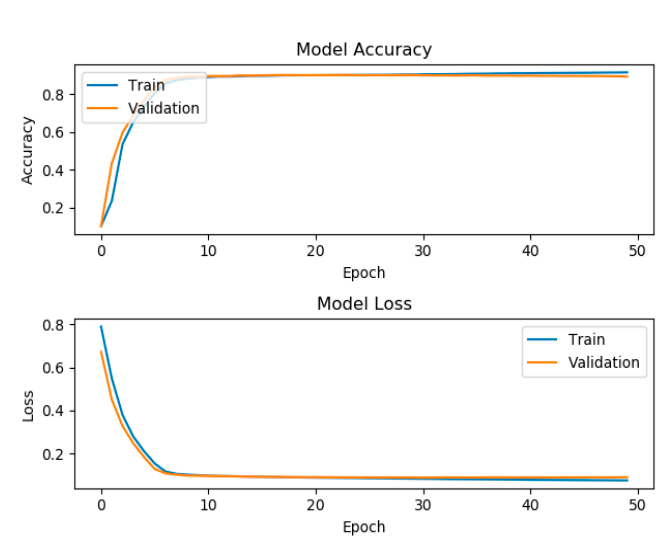
Figure A1. Siamese LSTM model accuracy and loss versus the four handled issue tracking system